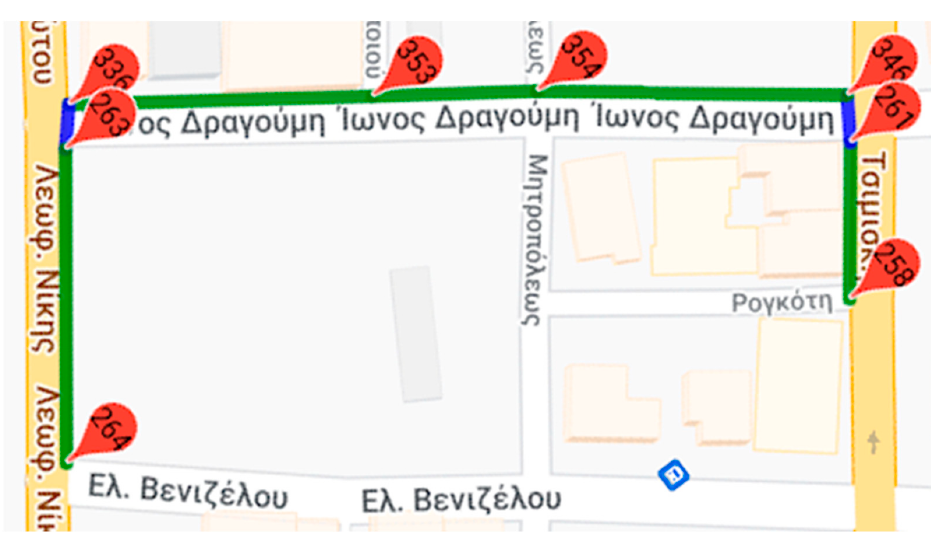
Figure 5. Most accessible path between nodes 258 and 264.